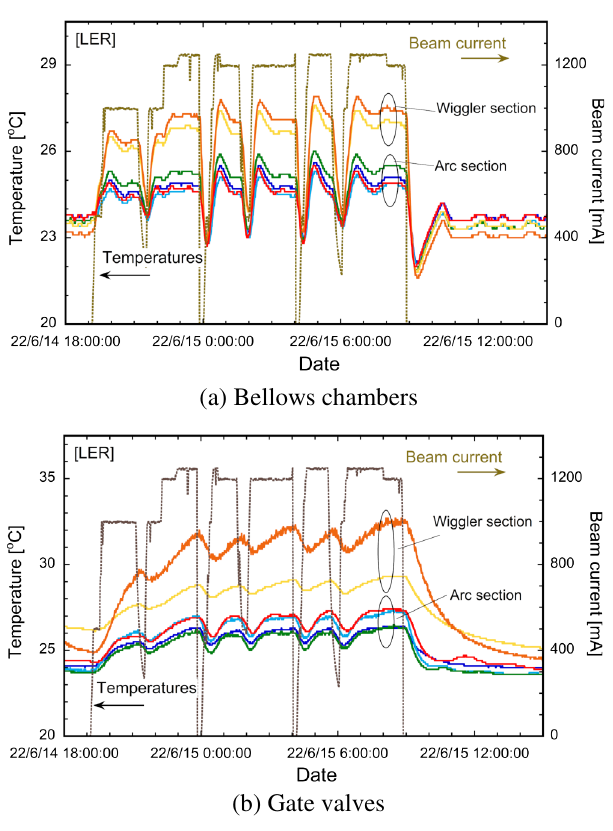
FIG. 6. Typical temperatures of (a) bellows chambers and (b) gate valves at wiggler and arc sections during a recent operation.